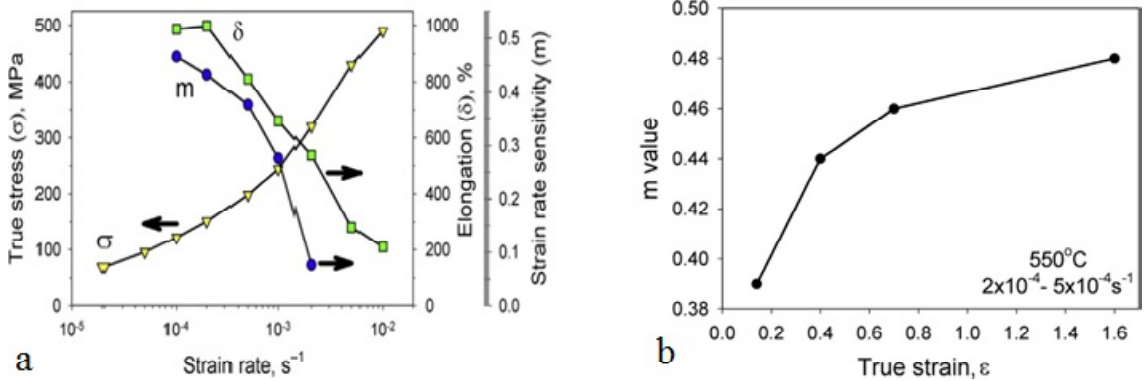
Fig. 3. Mechanical properties (a) and strain rate sensitivity coefficient m vs true strain at 550 °C in UFG Ti- 6Al-4V alloy. The stress was defined at  ~